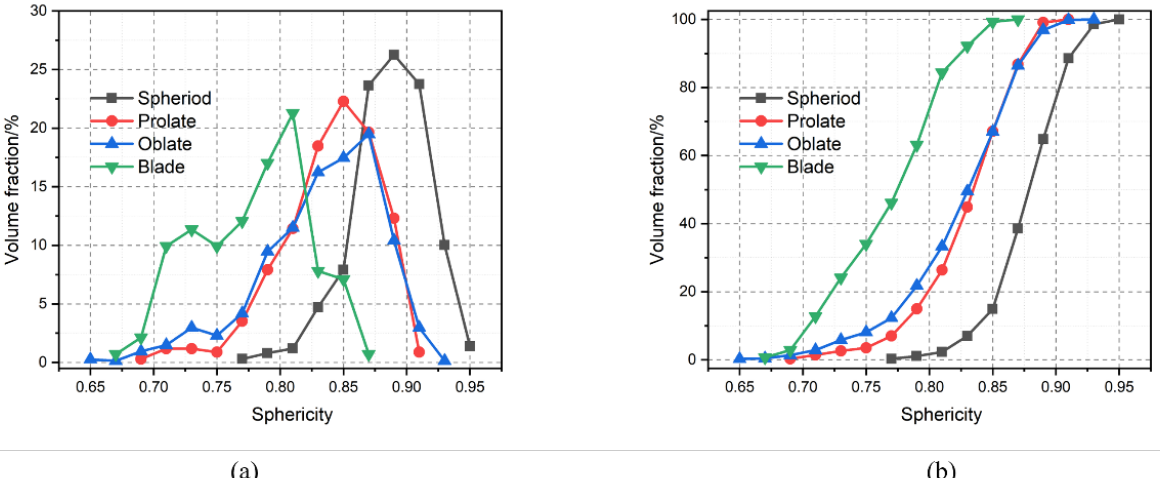
Figure 14. Volume-based distribution histogram of sphericity for desert sand particles belong to four categories: ( a ) differential; ( b ) cumulative.